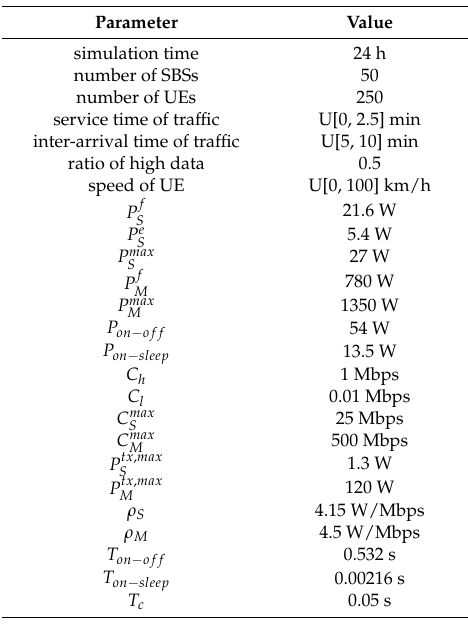
Table 3. Simulation parameters.